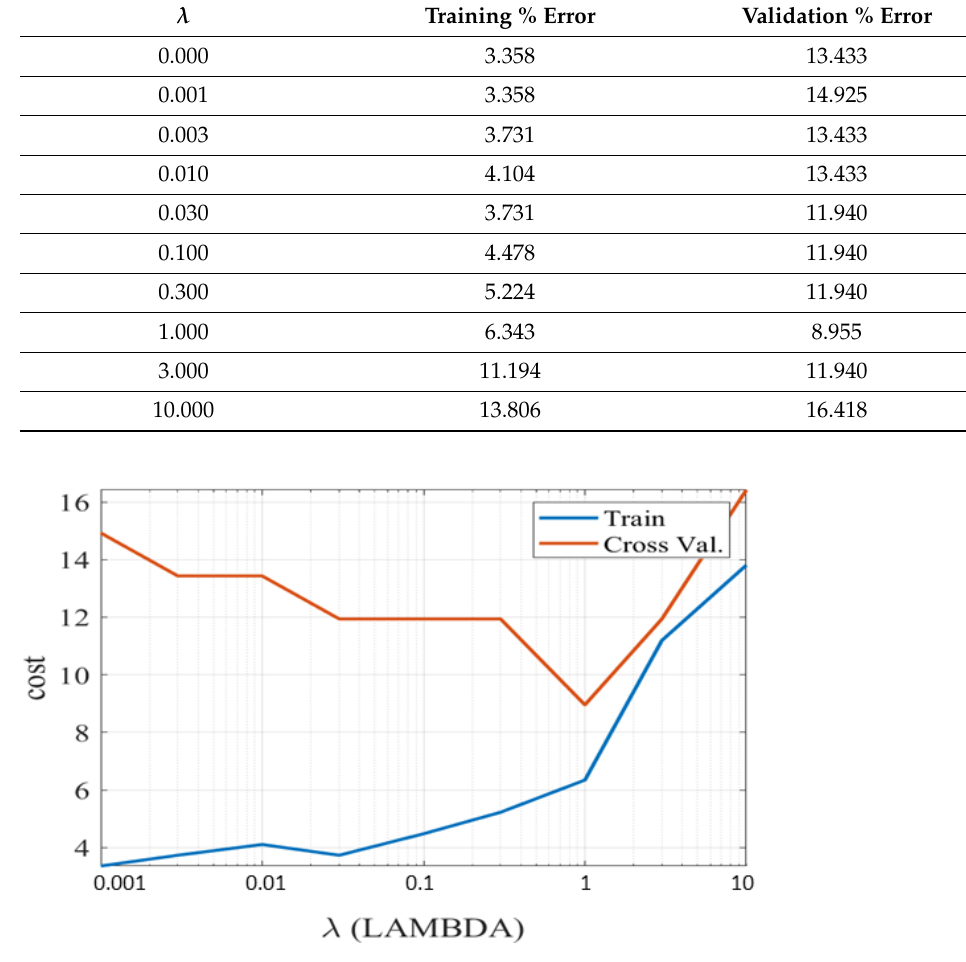
Figure 3. Selection of the regularization parameter using cross validation samples.